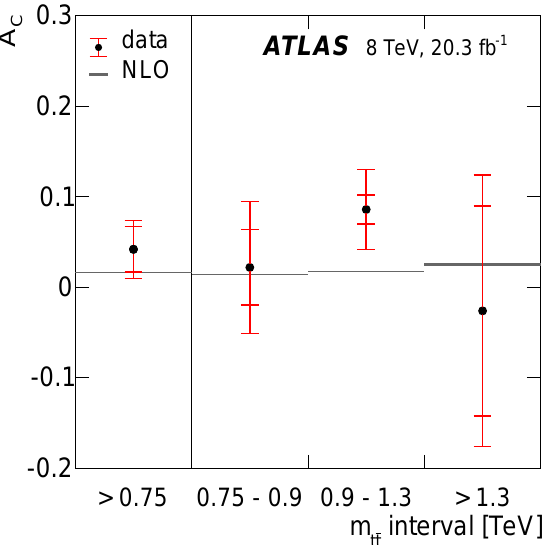
Figure 15. A t ¯ t values from the unfolded distributions as a function of m t ¯ t [48] compared to NLO C calculation